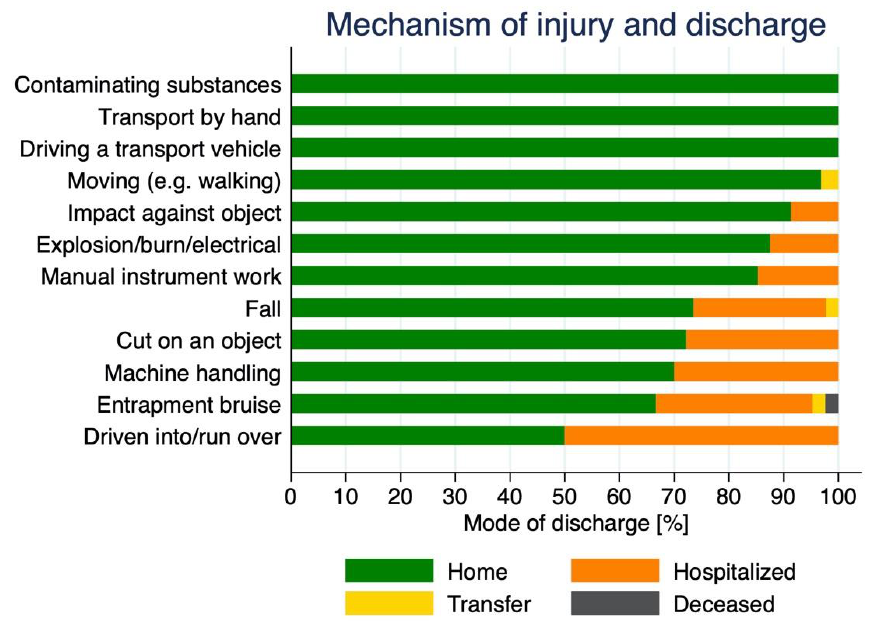
Figure 4. Relation between mechanism of injury and mode of discharge.